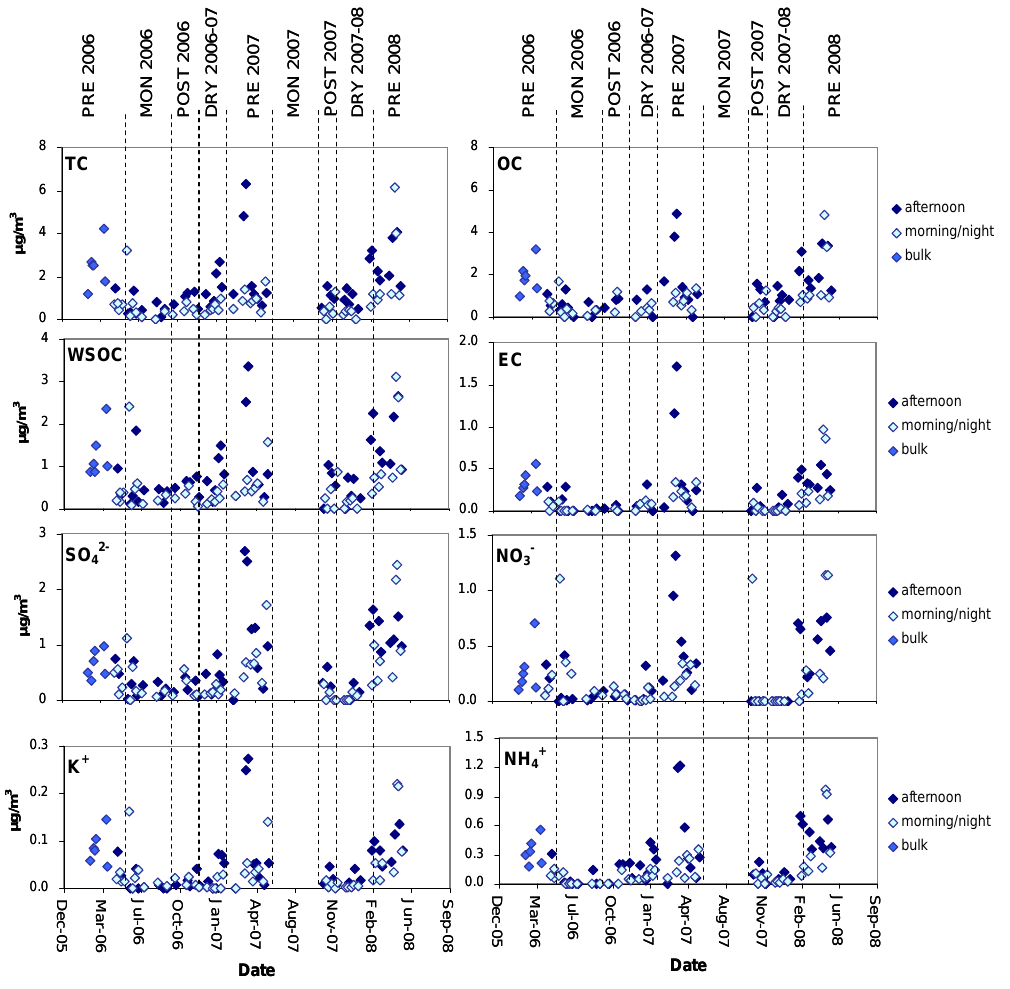
0.00.10.20.3 K + Fig. 1. Concentrations of the main ionic and carbonaceous species in PM 10 samples. separated on a IonPac AS11 2 × 250 mm Dionex separation column with a gradient KOH elution. Cations were sepa- rated on a IonPac CS16 3 × 250 mm Dionex separation col- umn, isocratically with a 30 mM solution of MSA as eluent. Detection limits were of the order of 0.02 and 0.01 µg m − 3 for each species and for daytime and night-time samplings,